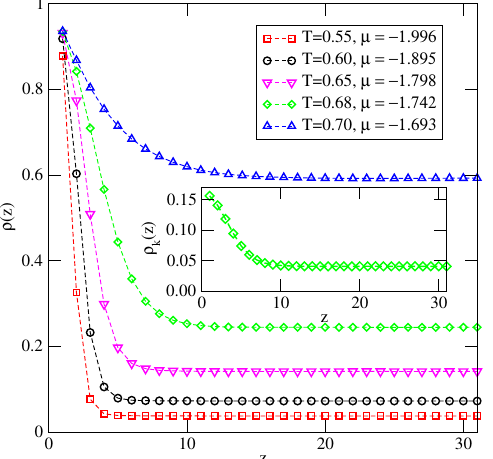
Figure 8. The local density profiles for the system u AB = 0, u BB = − 1.0 and V o = − 1.0, recorded at different temperatures (given in the figure) above the temperature of the dewetting transition and at the chemical potentials close to the bulk coexistence. The inset gives the profiles ρ k ( z ) at T = 0.68.